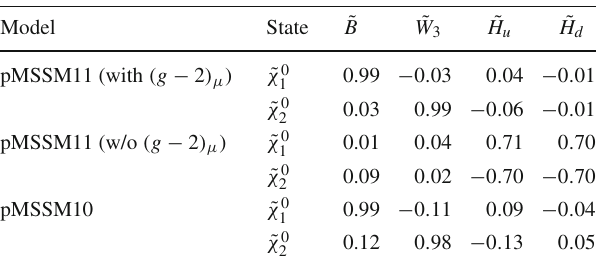
Table 6 The amplitudes characterizing the decomposition of the LSP ˜ χ 0 and of the ˜ χ 0 into interaction eigenstates at the best-fit points in our 1 2 presentpMSSM11analysisincludingLHC13-TeVdata,withandwith- outthe ( g − 2 ) μ constraint,comparedwiththecompositionatthebest-fit point found in our previous pMSSM10 analysis that also included the ( g − 2 ) μ constraint, but only LHC 8-TeV data